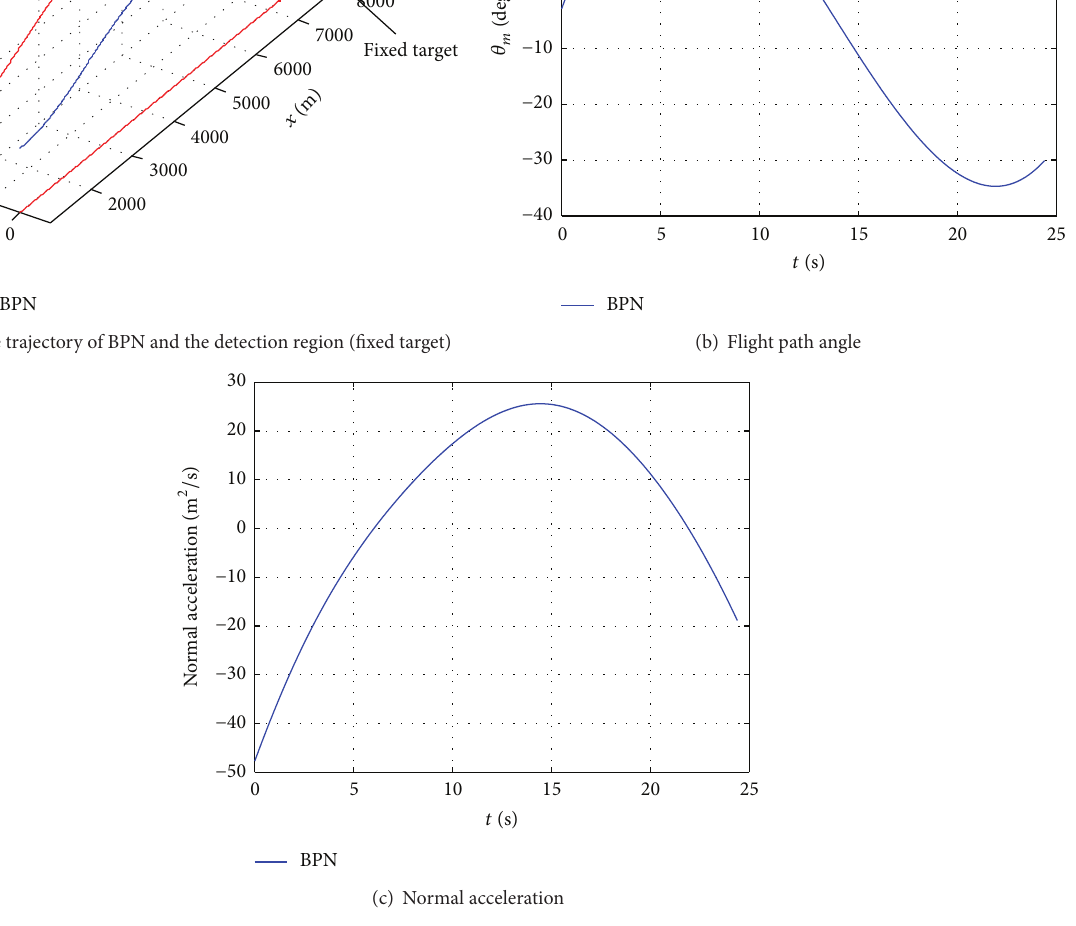
Figure 19: Midcourse simulation of BPN (fixed target).